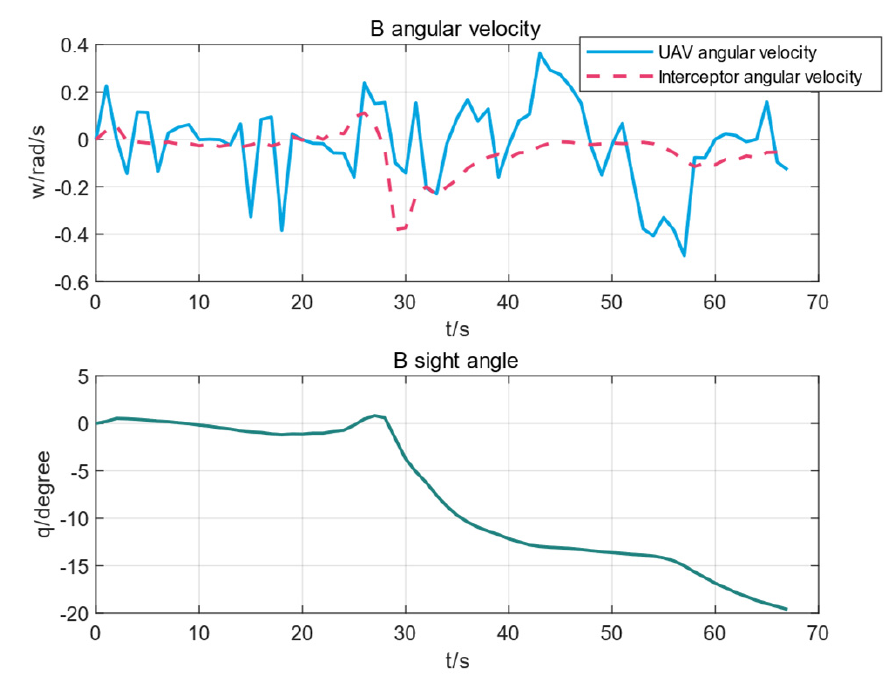
Figure 9. The parameter change curve of UAV B and Interceptor B during training. It can be seen from the figure that the UAVs carried out a wide-angle exercise, the interceptor’s line of sight to the UAVs continued to increase, and the interception failed. Figure 10 shows the distance curve between the two UAVs and the interceptor. The black line at the bottom of the figure represents the distance captured by the interceptor.